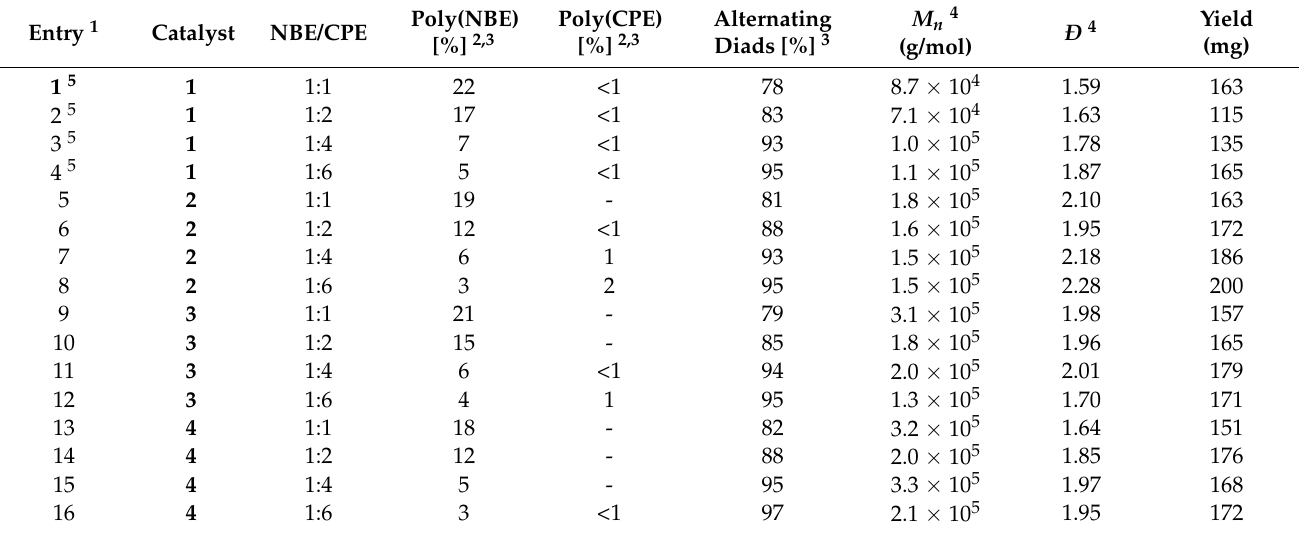
Table 2. ROMP copolymerization of NBE and CPE in the presence of catalysts 1 – 4 .